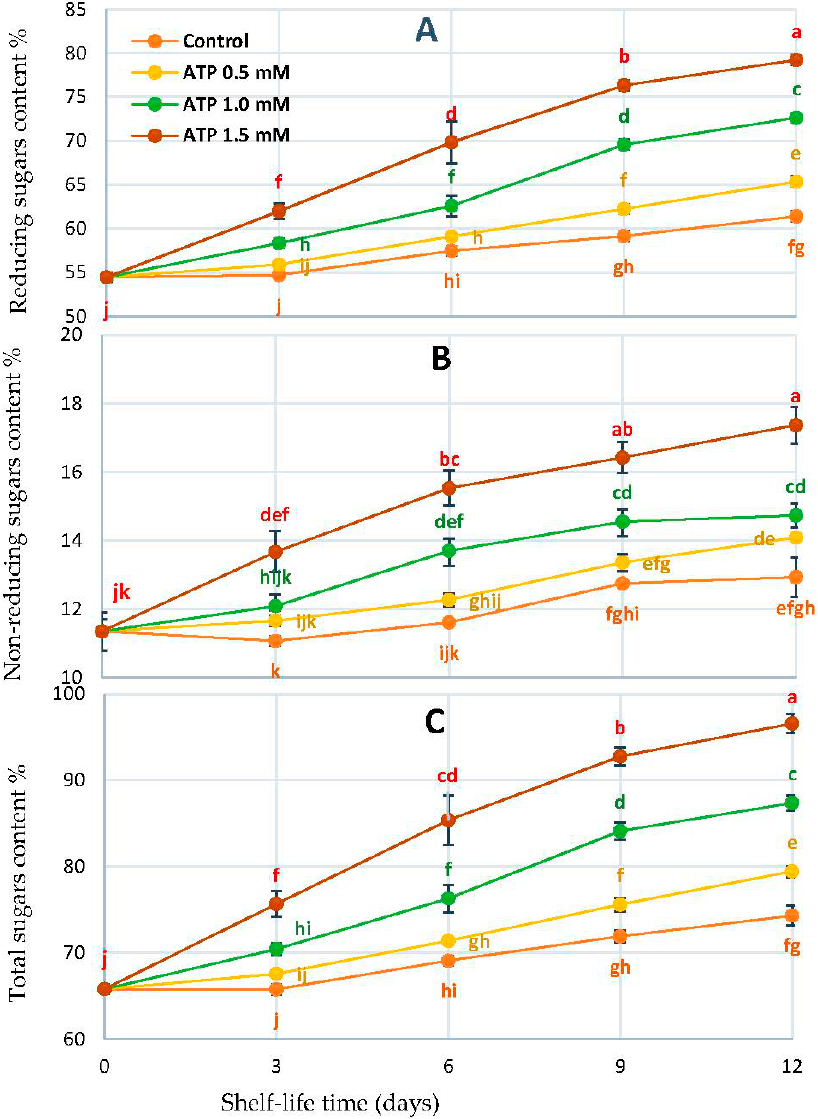
Figure 4. Reducing sugar ( A ), non-reducing sugar ( B ), and total soluble sugar ( C ), of ‘Zaghloul’ date fruit treated with ATP at different concentrations (0, 0.5, 1.0, and 1.5 mmol L − 1 ) during storage at 27 ± 1 °C, 67 ± 3% R, for 12 d. Each value represents mean ± SE ( n = 3). The letters differ ( p < 0.05) and represent the significance between treatments using the Tukey–Kramer HSD test to compare the different treatments.